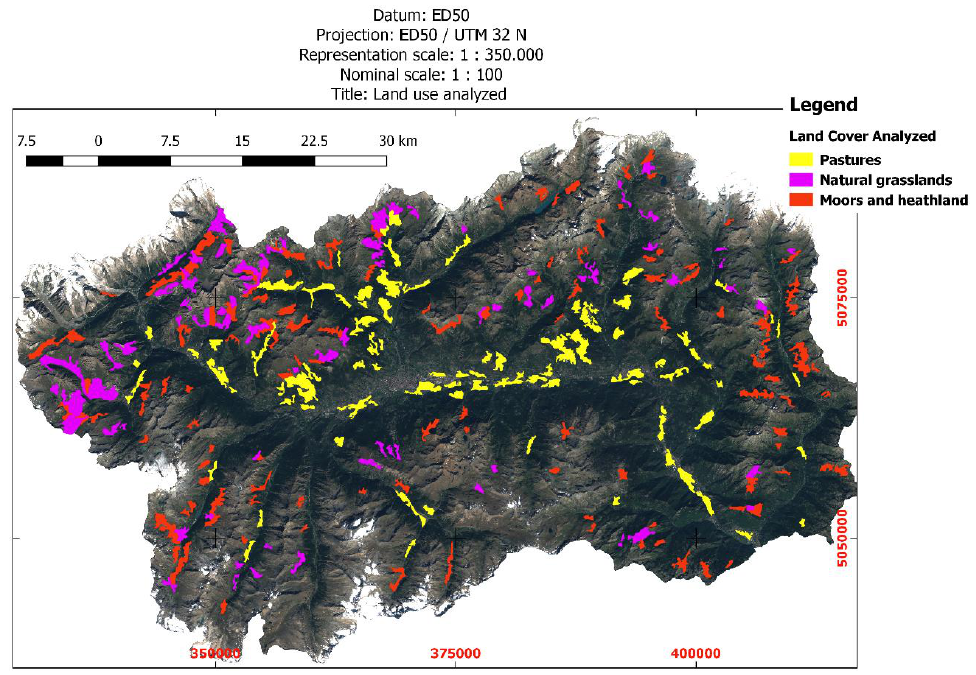
Figure 4. Map showing spatial distribution of land cover classes (from CORINE land cover map) that were considered for the study: pastures, natural grasslands, and moors / heathland.